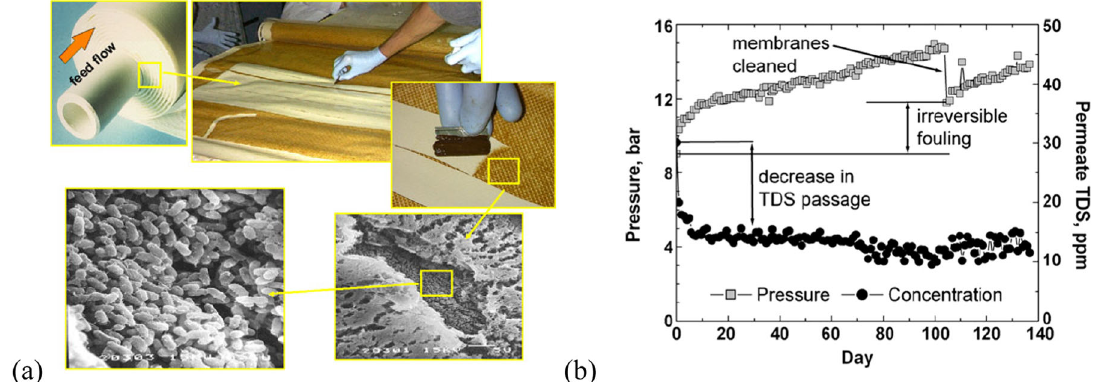
Fig. 4 Images and data indicating biofouling at a municipal water recycling RO plant. a Pictures and SEM images of bio fi lms formed on RO membranes at the Orange County Water District (Fountain Valley, California, USA). 16 . b Feed pressure (gray squares) and permeate TDS (black circles) for the duration of the 140 day pilot study. Copyright